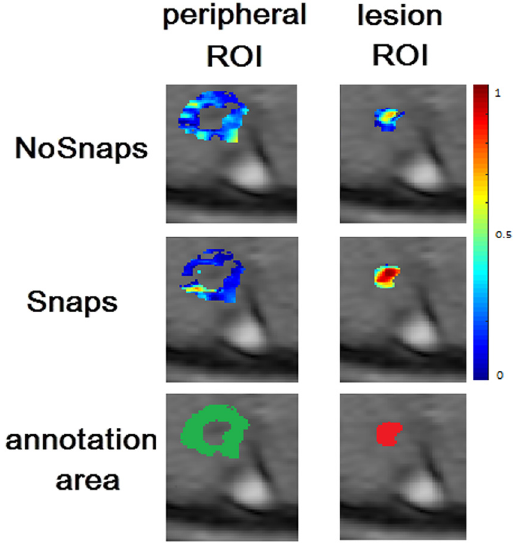
Figure 4: An exemplary fi gure depicting the adj - R 2 of the periphery of the lesion ( fi rst column ) and the active lesion ROI ( second column ) for the NoSnaps ( fi rst row ) and Snaps ( second row ) protocols using the ET model. In the third row, the annotation areas for the periphery of the lesion ( green ) and the active lesion ( red ) are depicted. Pixels that are not assigned with an adj - R 2 value and are included in the lesion or peripheral ROI are those pixels for which the fi tting algorithm did provide reasonable perfusion parameters so they were